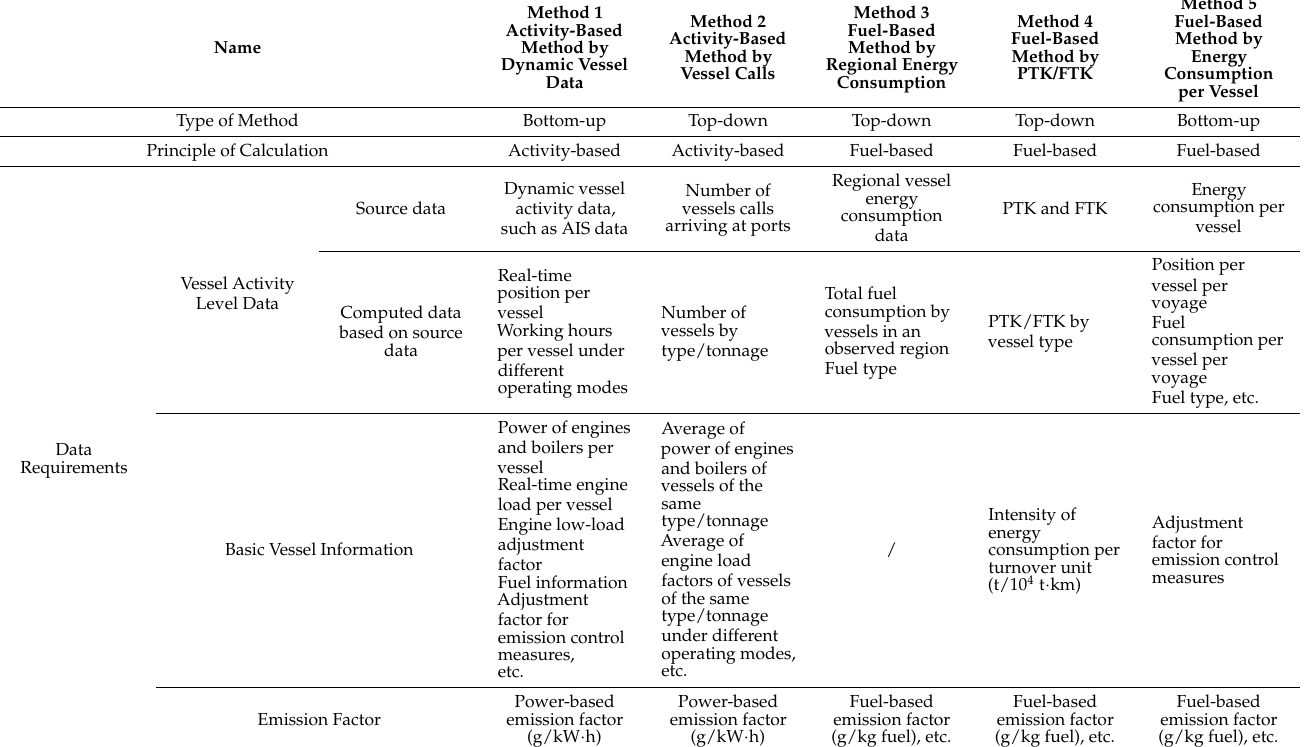
Table 1. Calculation principle and required data of the main